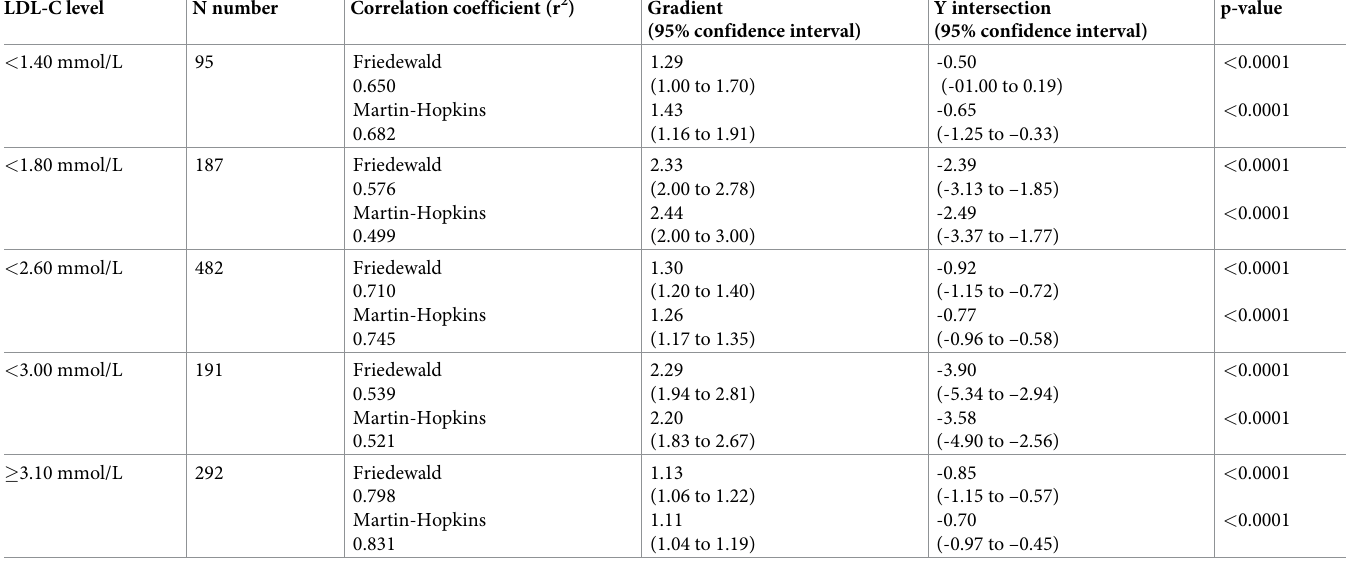
Table 2. Summary of the comparison between measured and calculated low-density lipoprotein (LDL-C), using the Friedewald and Martin Hopkin formulae as well as regression analysis at different LDL-C levels. LDL-C